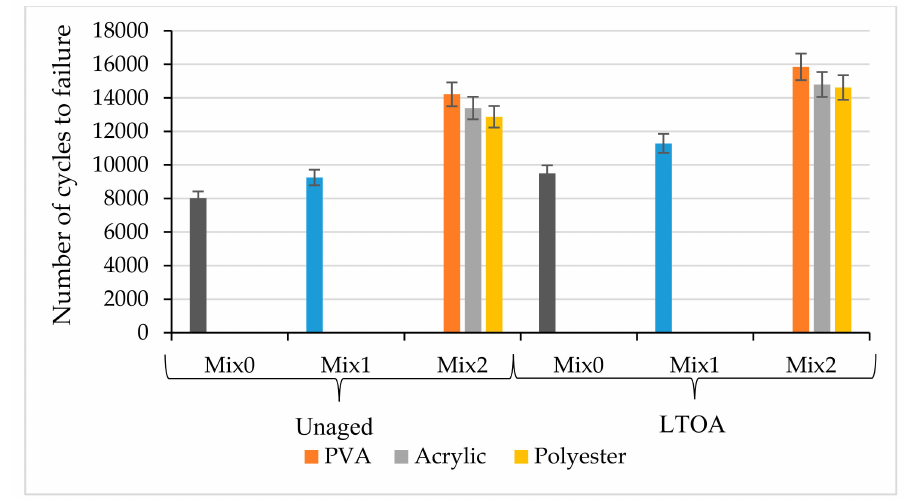
Figure 8. Number of cycles to